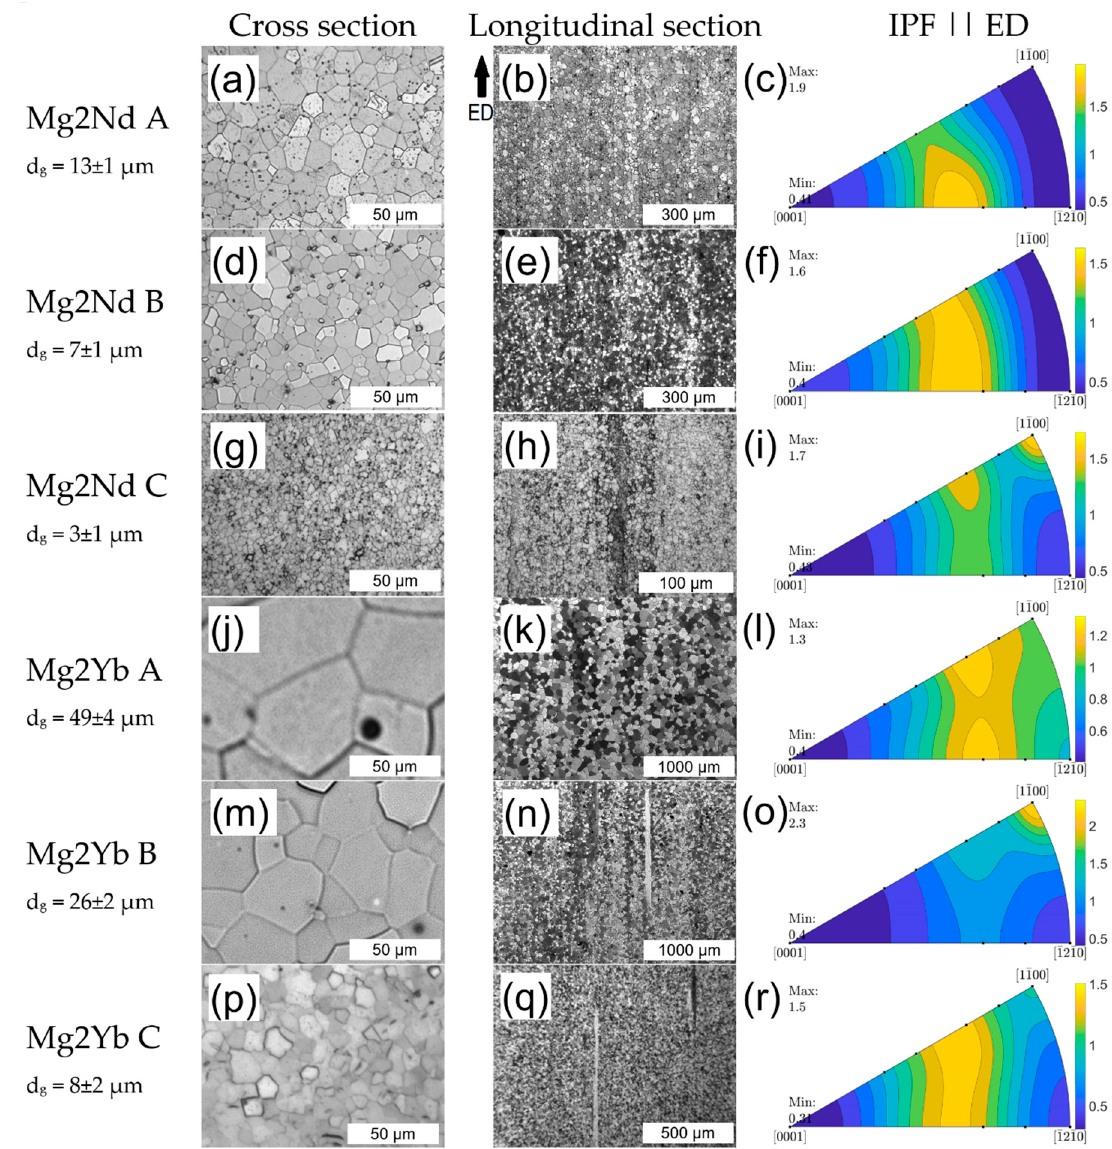
Figure 1. Cross section, longitudinal section, and inverse polfigures in the extrusion direction (ED) of the Mg2Nd alloy ( a – c ) A-series, ( d – f ) B-series, ( g – i ) C-series, and of the Mg2Yb alloy ( j – l ) A-series, ( m – o ) B-series, ( p – r ) C-series.